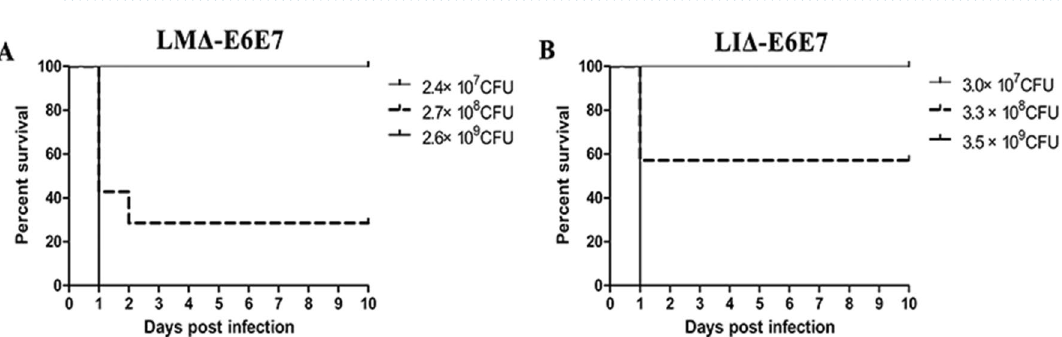
Figure 2. The survival of mice after intravenous injection with the recombinant strain. C57BL/6J mice (7 mice/ group) were injected with a gradient-increased dose of LMΔ-E6E7 ( A ) or LIΔ-E6E7 ( B ). Then the mice were monitored for the next 10 days. Experiments were carried out at least three